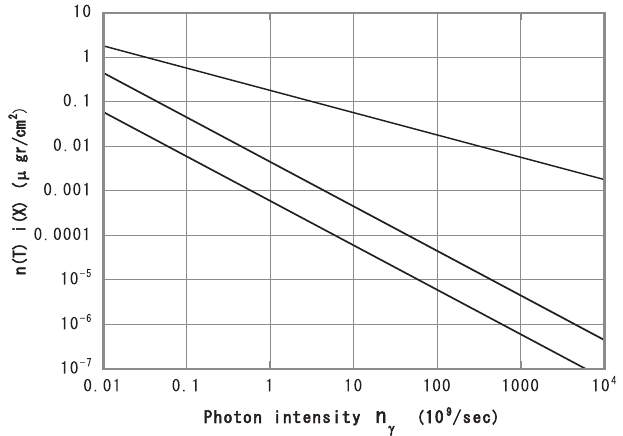
FIG. 1. Sensitivities of RPID in cases of A: low-BG singles measurements as given by Eq. (8); B: low-BG coincidence measurements as given by Eq. (9); and C: singles measurements with BGs from photonuclear reaction products of n ð T Þ ¼ 5 gr = cm 2 sample as given by Eq. (14),